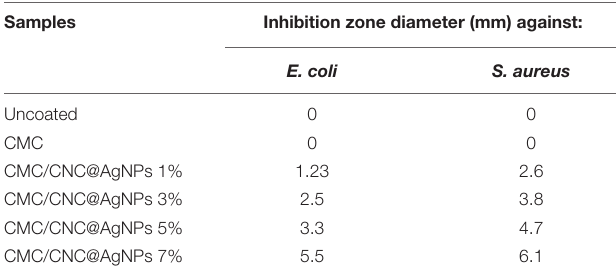
TABLE 2 | Inhibition zone Diameter of coated and uncoated paper exposed to E. coli and S. aureus [Reproduced with permission from Wu et al. (2018)]. Samples Inhibition zone diameter (mm)